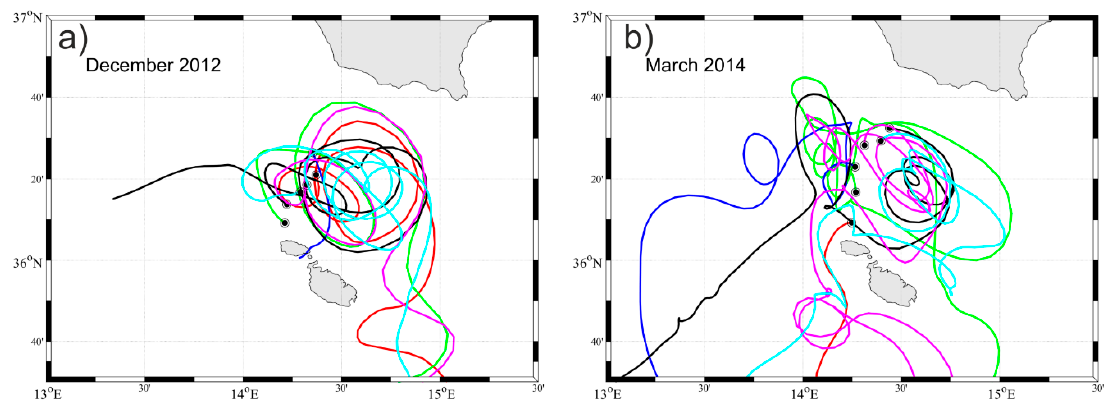
Figure 9. Trajectories and deployment positions (black dots) of the drifters deployed on the Malta Plateau in December 2012 ( a ) and March 2014 ( b ).